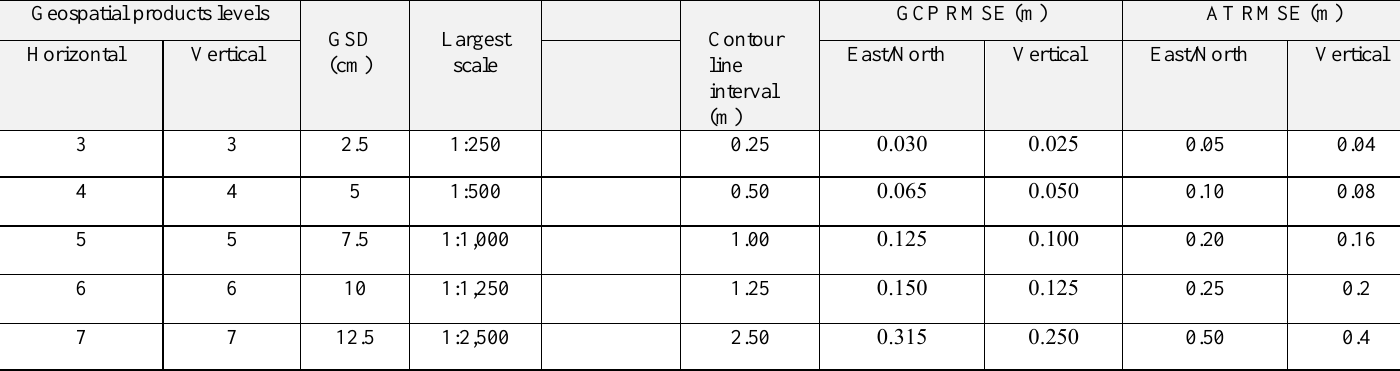
Geospatial products